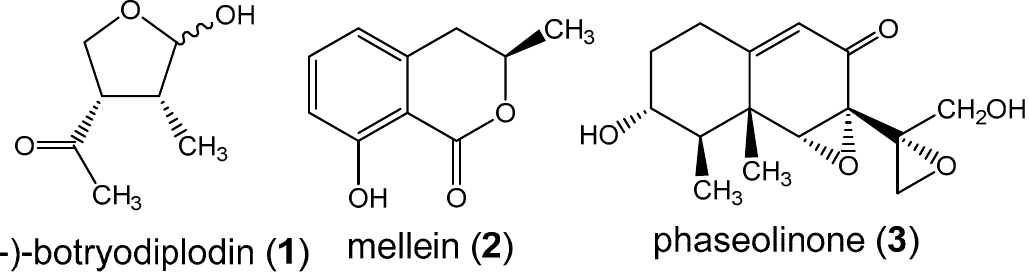
Figure 1. Structures of some previously reported toxins from Macrophomina phaseolina cultures, (-)- botryodiplodin ( 1 ), mellein ( 2 ) and phaseolinone ( 3 ). (-)-botryodiplodin ( 1 ), mellein ( 2 ) and phaseolinone ( 3